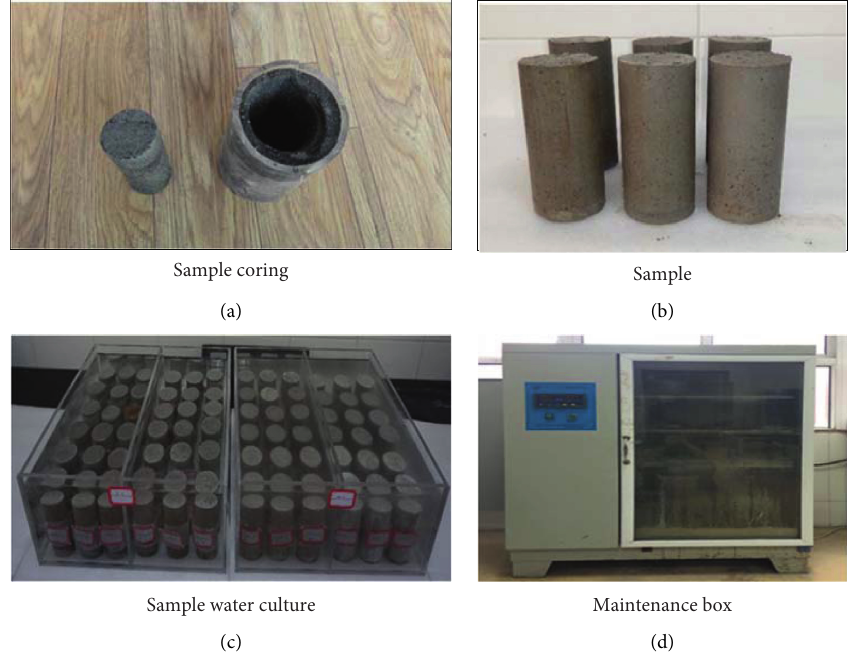
Figure 2: Coring and curing of grouted body sample: (a) sample coring; (b) sample; (c) sample water culture; (d) maintenance